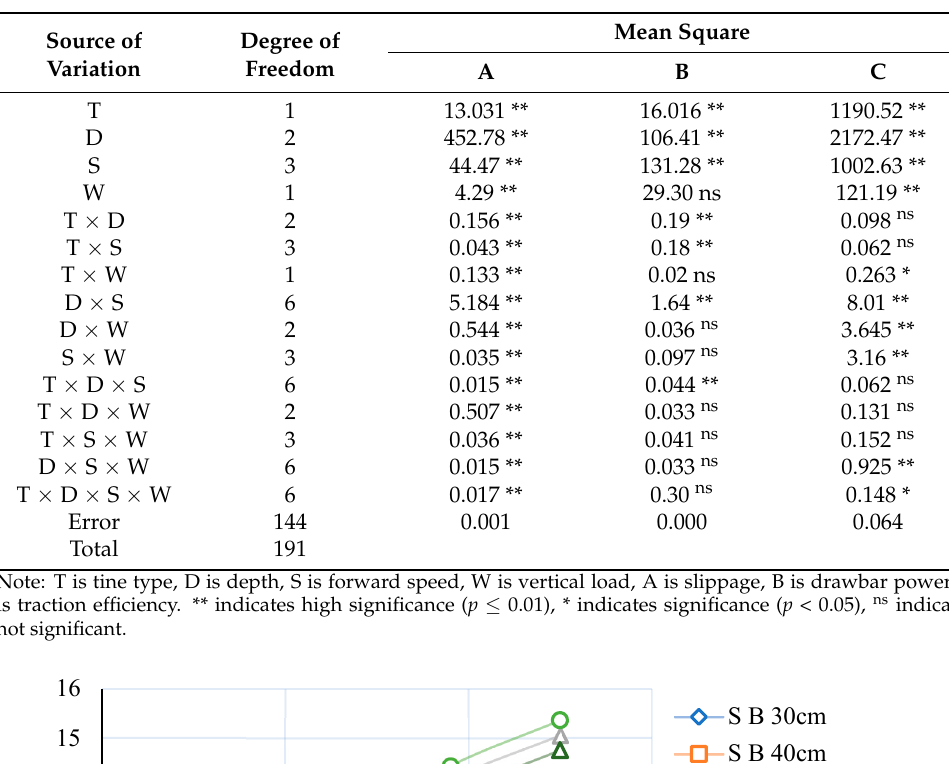
Table 2. Analysis of variance (ANOVA) of tine, depth, speed and vertical load (ring weight) on the parameters of this study (drawbar power, traction efficiency and slippage).